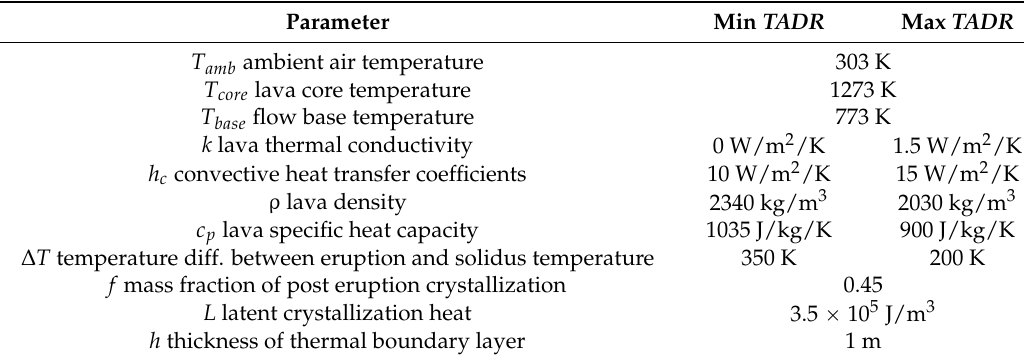
Figure 6. Minimal and maximal values of TADR in m 3 /s, obtained from TET-1 data. Table 6. Input parameters for TADR estimation